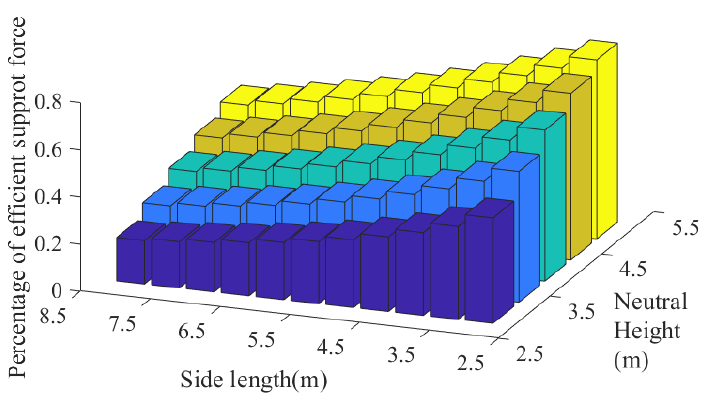
Figure 19. Correlation between the percentage of vertically support force of branch legs and neutral height under di ff erent side length circumstances.